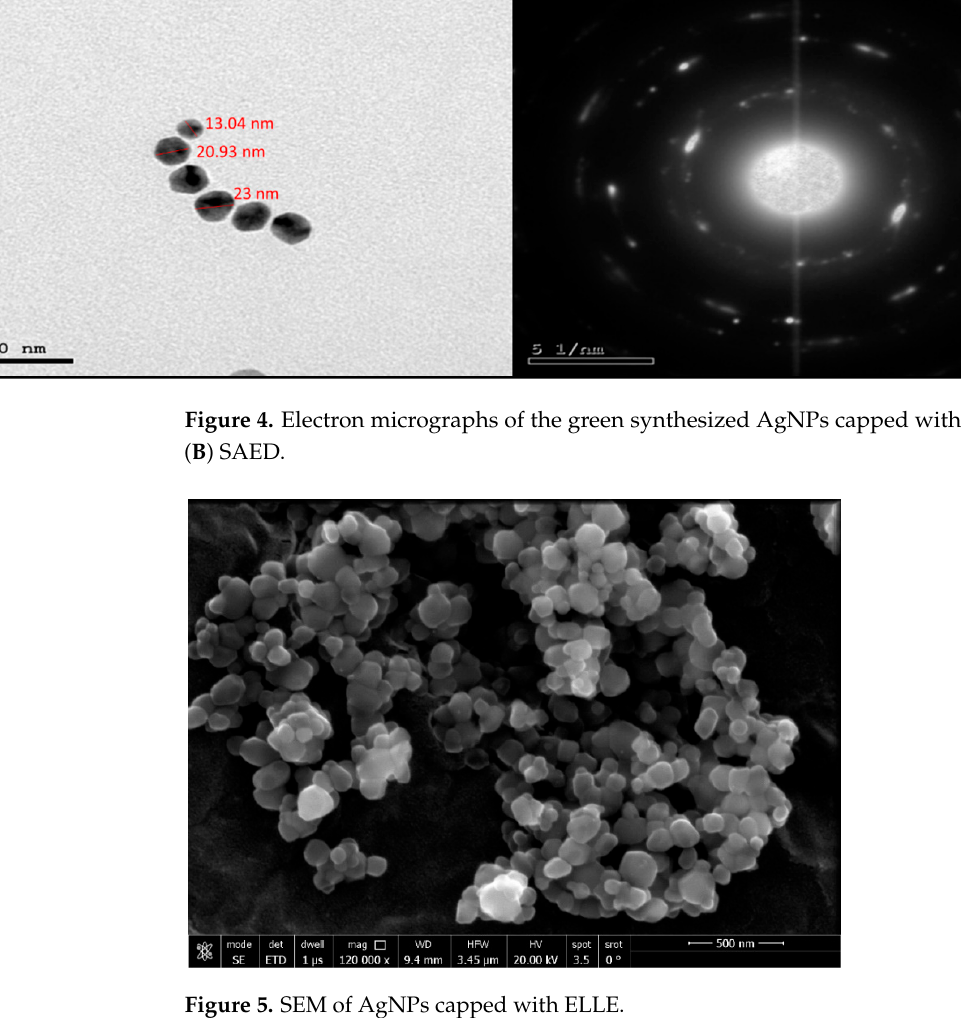
Figure 5. SEM of AgNPs capped with ELLE.